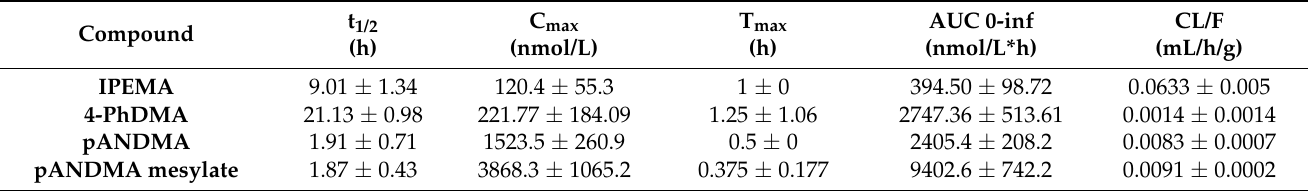
Table 4. Main PK parameters of the selected compounds.